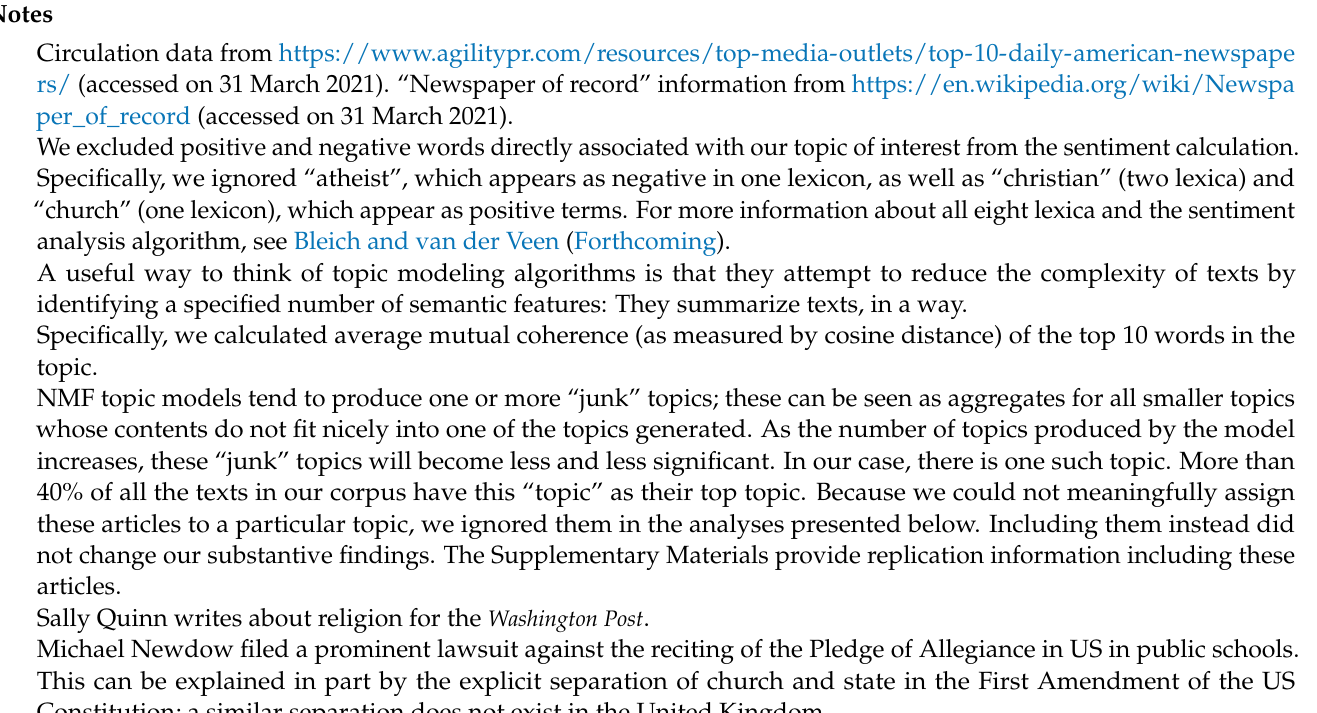
Table S2: Topic model: overview of the 16 topics in the atheist corpus, Table S3: Tone of coverage and top adjective collocates in articles on non-foreign topics: atheism vs.